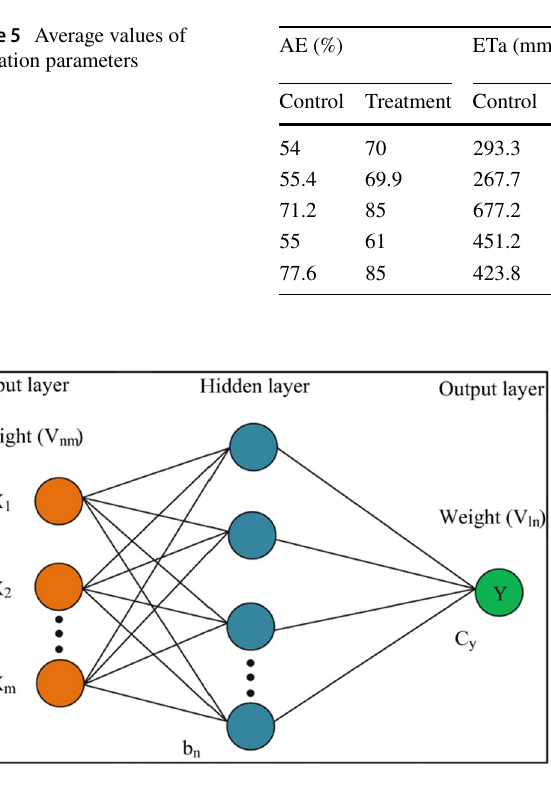
Fig. 2 Schematic of the ANN model